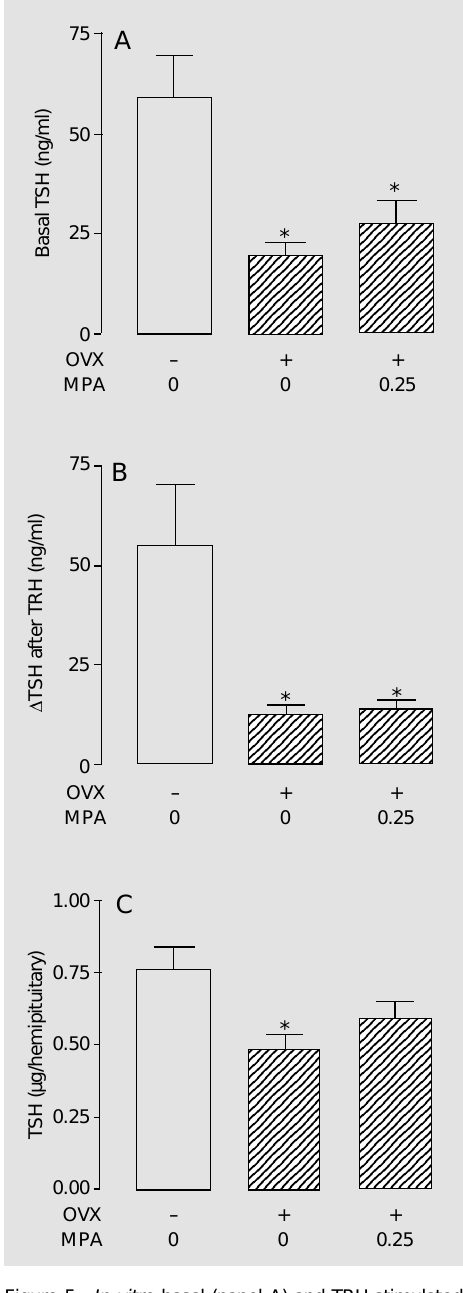
Figure 5 - In vitro basal (panel A) and TRH-stimulated (panel B) TSH release from hemipituitaries of 23-month- old sham-operated or ovariectomized (OVX) rats treated with medroxyprogesterone acetate (MPA, 0.25 mg/ 100 g body weight, sc , for 9 days) or saline. After incubation, pituitary TSH content was measured (panel C). Number of hemipituitaries per group: 8-9; *P<0.05 vs normal (ANOVA followed by Newman-Keuls test). D TSH values were calculated as the difference be- tween medium TSH and basal TSH after